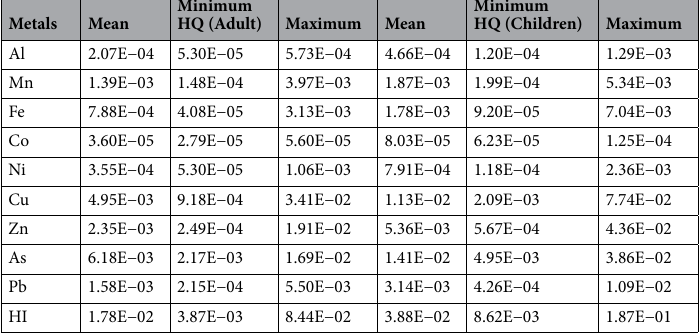
Table 10. Total Hazard Quotient and Health risk index (HI) for trace metals in the water